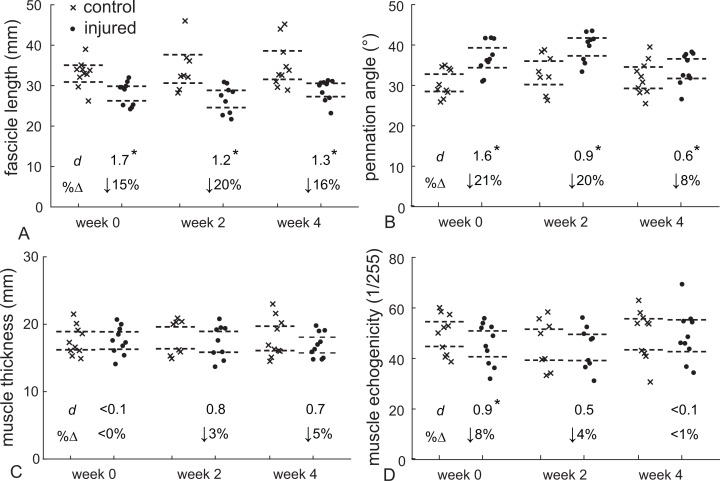
Muscle structure following Achilles tendon rupture.Medial gastrocnemius structure following Achilles tendon rupture (closed circles) was compared to the contralateral muscle (control - crosses) at each time point. Resting fascicle length (A) decreased while pennation angle (B) increased in similar proportions, which explained the stable muscle belly thickness (C) following 4 weeks of injury. Muscle echogenicity (D) decreased by 8% at week 0 but returned to non-injured values at weeks 2 and 4. (*P < 0.017, dashed lines—95% confidence intervals, d—Cohen’s effect size, %Δ—percent change from control data, week 0 – N = 10, week 2 – N = 8, week 4 – N = 10).